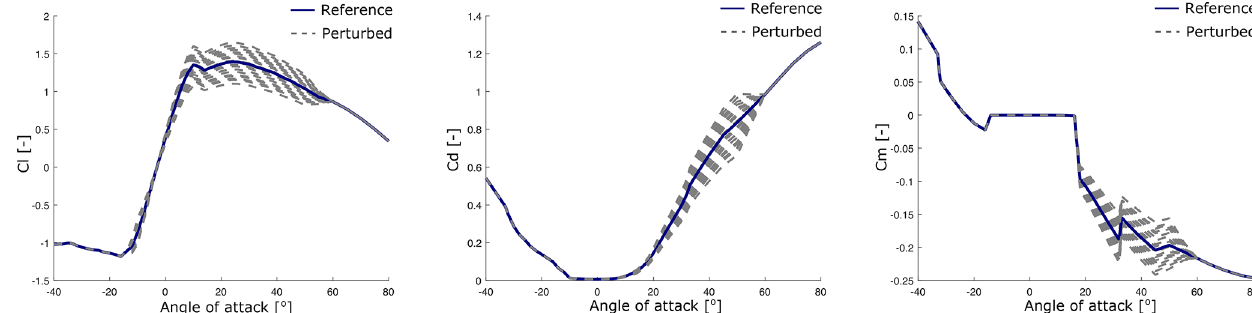
Figure 4. Examples of perturbed C l , C d , and C m polars at Sect. 2 as described by Eq. (5), with α min = − 10 ◦ and α max = 50 ◦